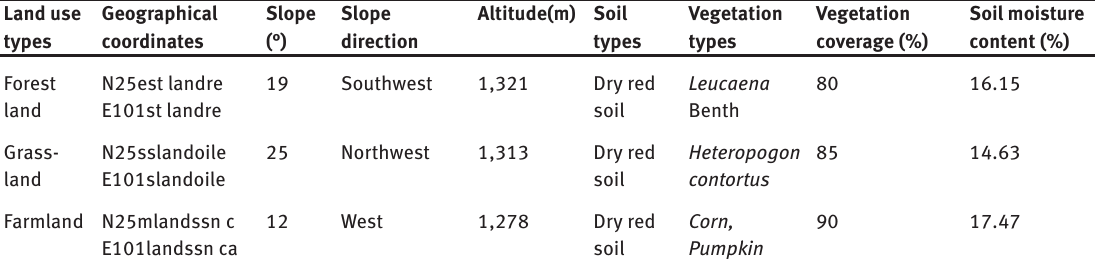
Table 1: Basic features to different land use